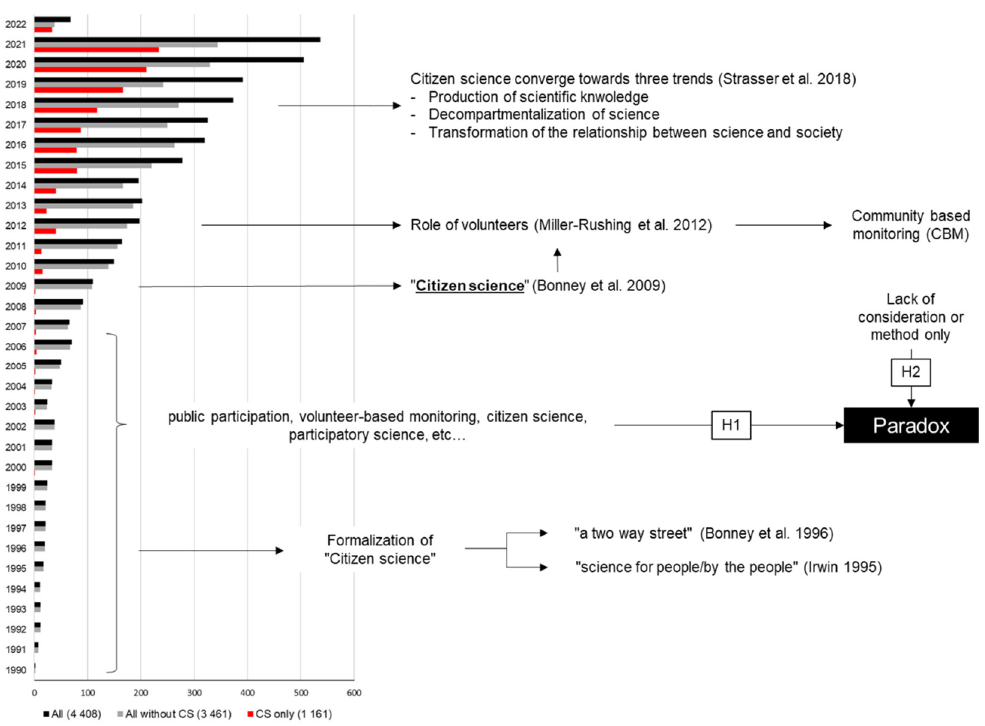
Figure 1. Figure showing the main steps of citizen science formalization according to the literature and following the evolution of the number of scientific publications referenced in the Web of Science core collection database (histogram on the left). The histogram represents the number of scientific publications published (extracted in March 2022) per year including “citizen science” (red bars, CS only, Table 1) in their title, abstract or keywords according to the Web of Science core collection database. The black bars represent the number of publications found using 30 keywords (All, Table 1). The grey bars represent the number of publication found using the 29 keywords (All without CS, Table 1). H1 and H2 represent the two main hypotheses allowing understanding of the citizen science paradox. CS: citizen